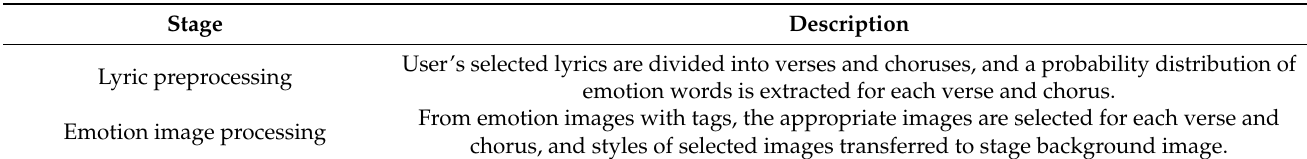
Table 2. Process for transforming stage background image style based on song lyrics. Stage Description Lyric